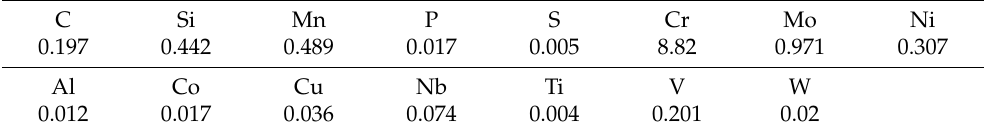
Table 1. Chemical composition of P91